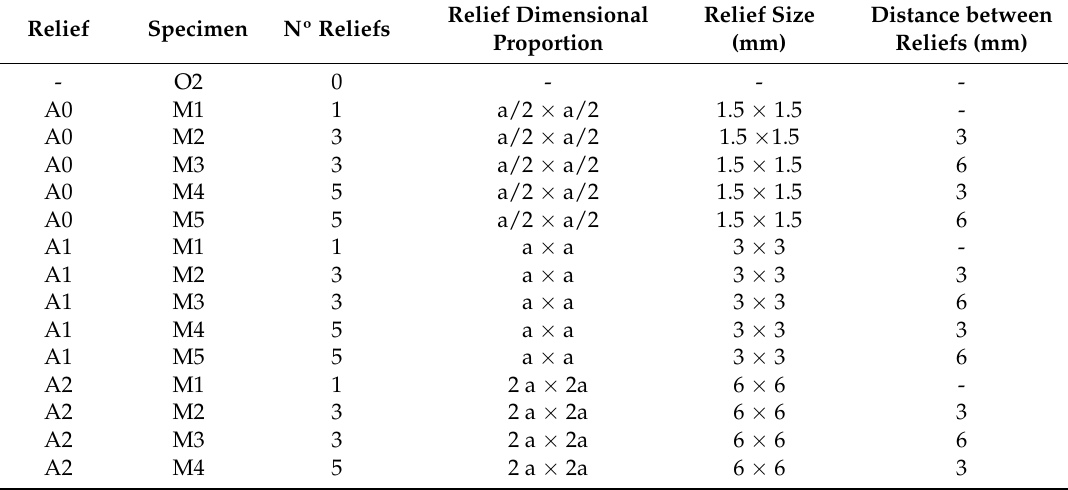
Table 2. Nomenclature of reliefs according to the type of relief, distance and dimensional correspondence.